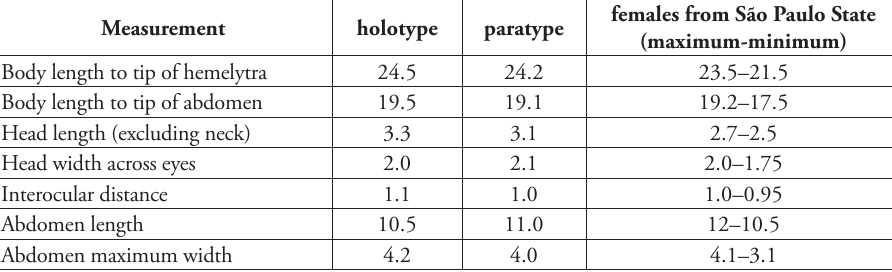
Table 3. Selected measurements (mm) of female specimens of P. salgadoi